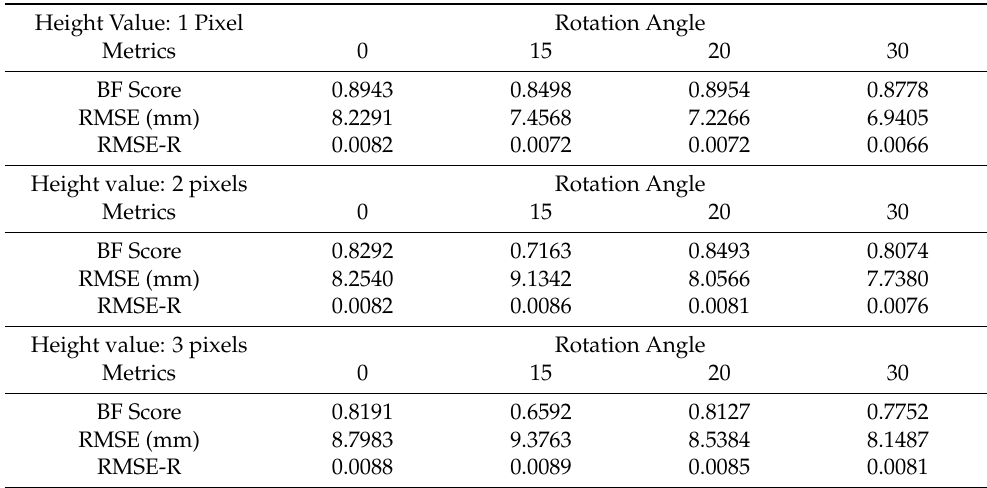
Table 7. Synthetic linear motion blur